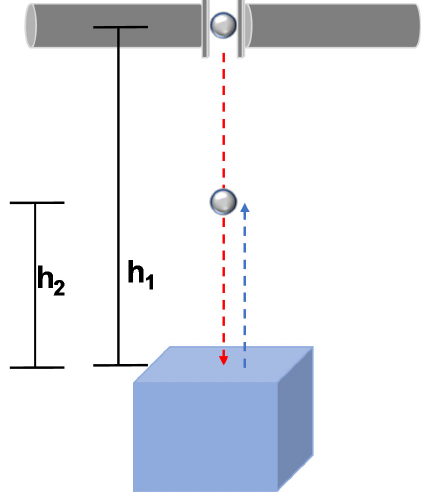
Figure 3. A schematic representation of glass ball impacting on the surface of base block showing initial drop height (h 1 ) and rebound height (h 2 ).